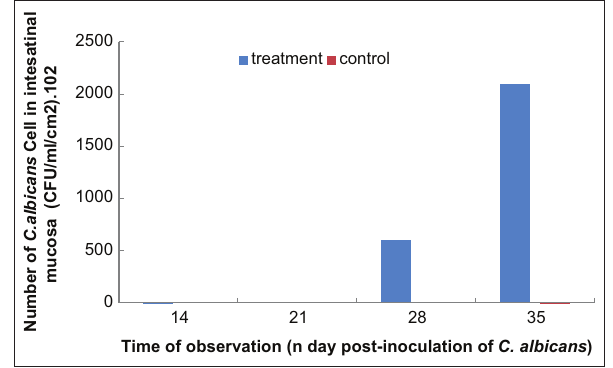
Figure-2: The density of Candida albicans cells in the intestinal